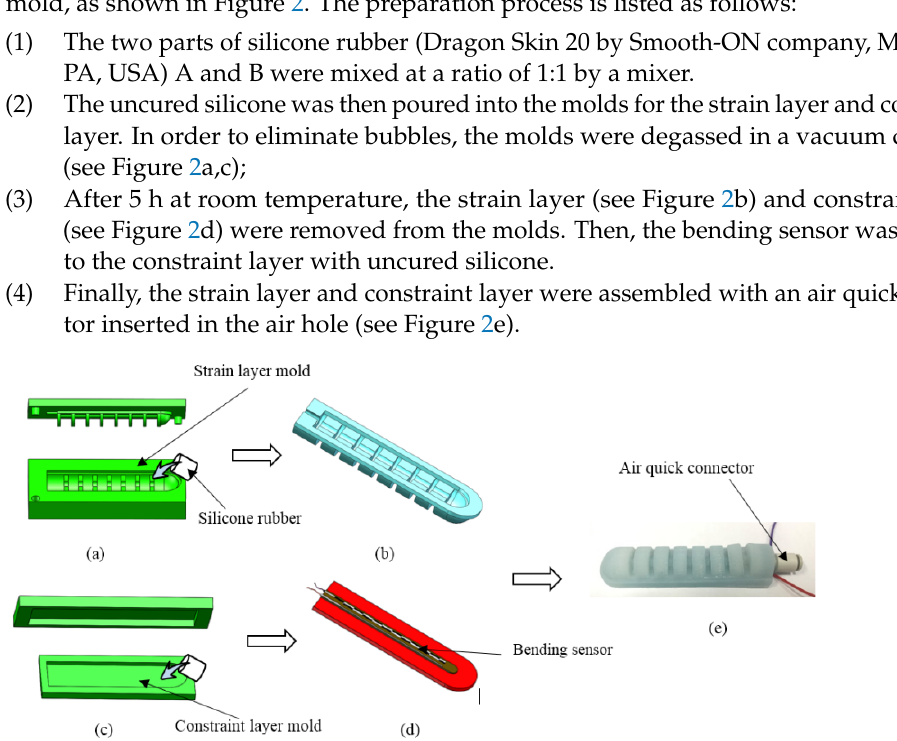
Figure 2. Soft actuator preparation flow chart. ( a ) Preparation of strain layer with mold. ( b ) Pre- pared strain layer. ( c ) Preparation of limiting layer. ( d ) Attachment of the bending sensor. ( e ) The assembled soft manipulator.